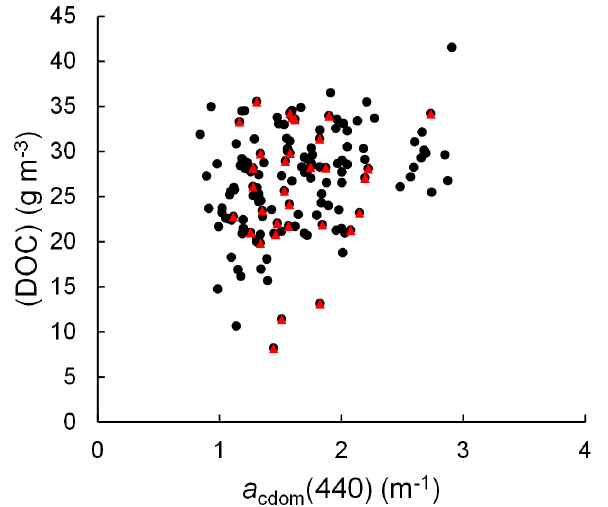
Figure 4. Scatterplot showing measured DOC concentrations ((DOC)) versus concentrations of colored dissolved organic matter ( a cdom (440)) for samples collected for the Wabash River (circles) and the Tippecanoe River (triangles) in summer 2014.